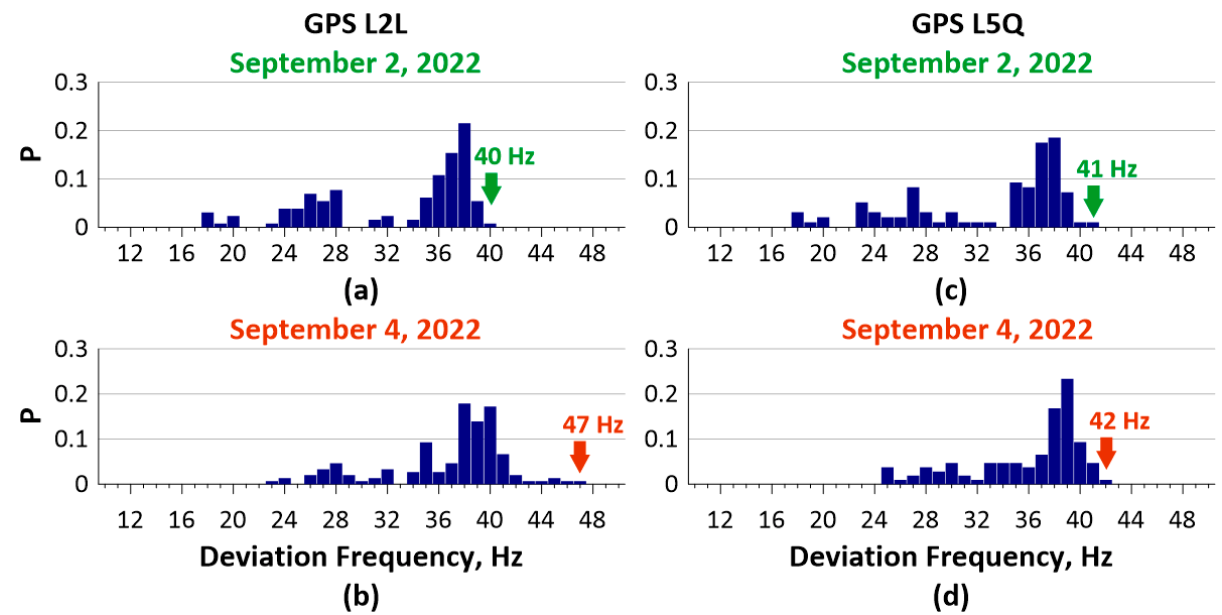
Figure 6. The deviation frequency fd distribution for 100 Hz data of L2L and L5Q GPS signals under quiet conditions on 2 September 2022 ( a , c ) and during the magnetic storm on 4 September 2022 ( b , d ).